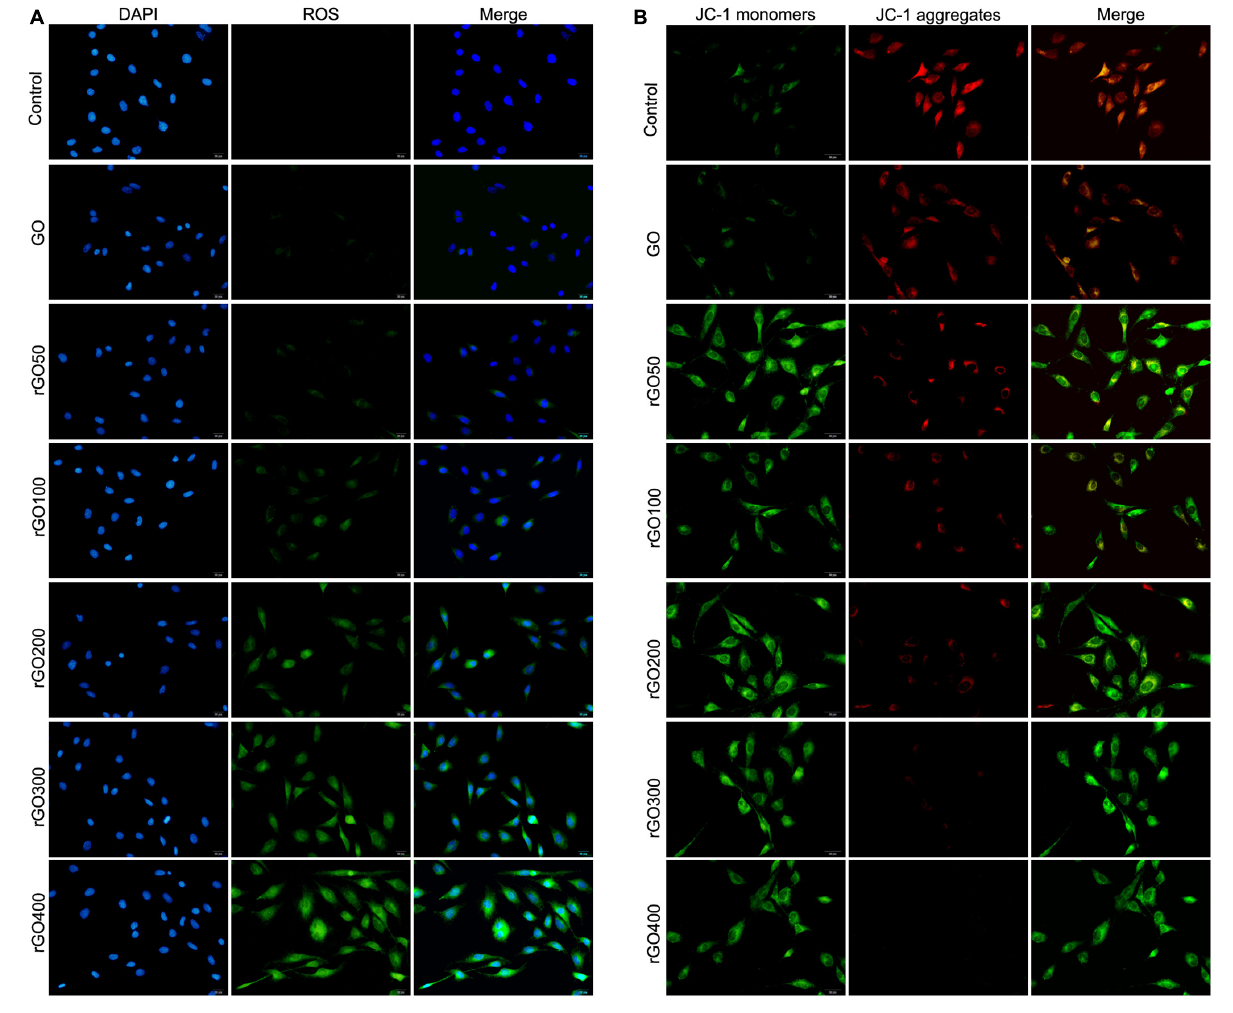
FIGURE 3 | Graphene oxide (GO) and reduced GO (rGO) induced oxidative damage and mitochondria damage in H9C2 cells. (A) Reactive oxygen species (ROS) content in H9C2 cells treated with GO or rGO using the DCFH-DA staining kit. (B) The mitochondrial membrane potential in H9C2 cells treated with GO or